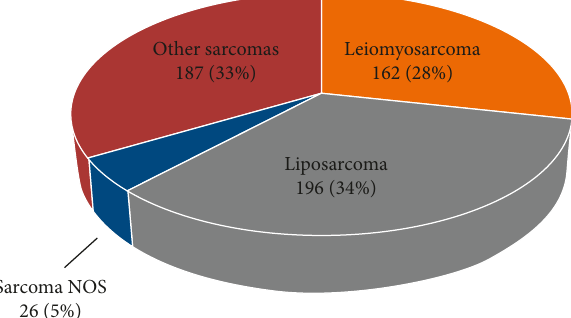
Figure 1: Pie chart demonstrating proportion of different histo- logical subtypes.